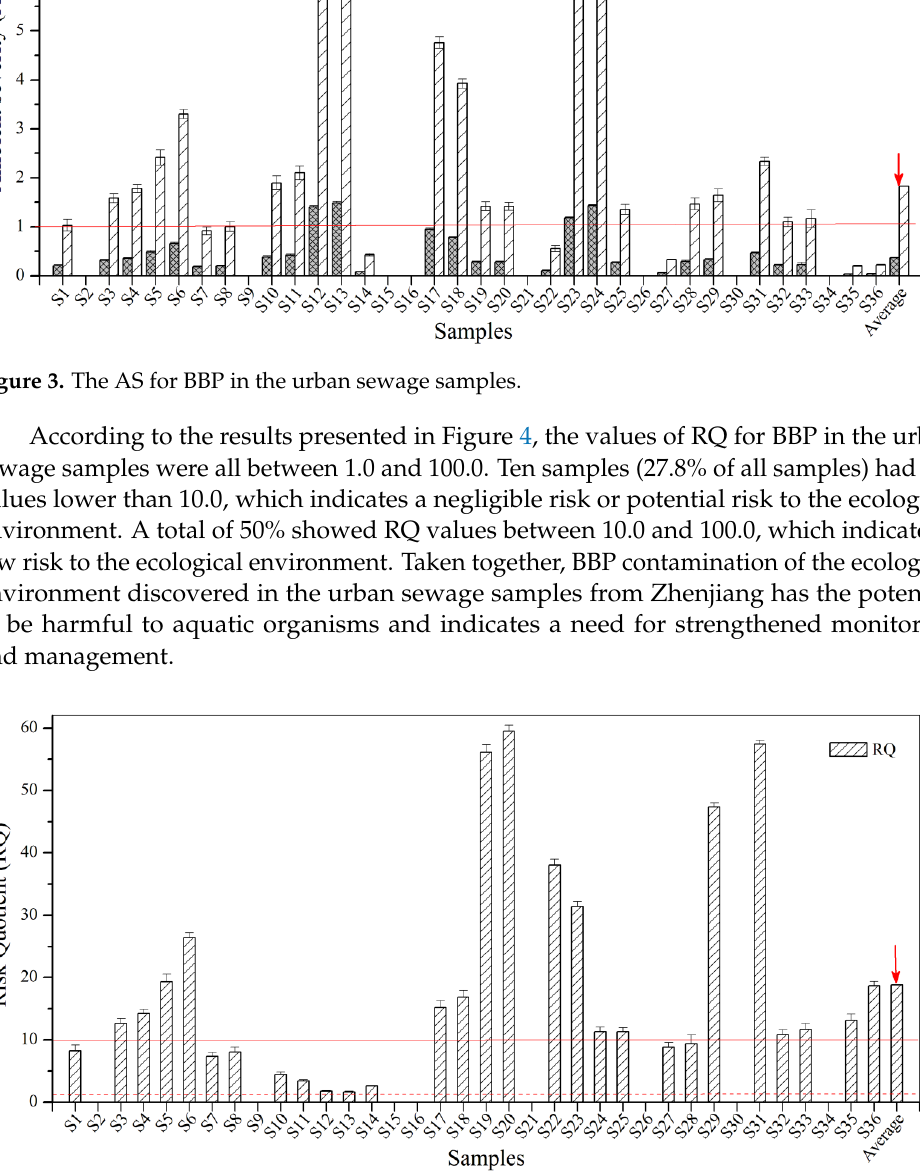
Figure 5. The HI drink for BBP in the urban sewage samples.